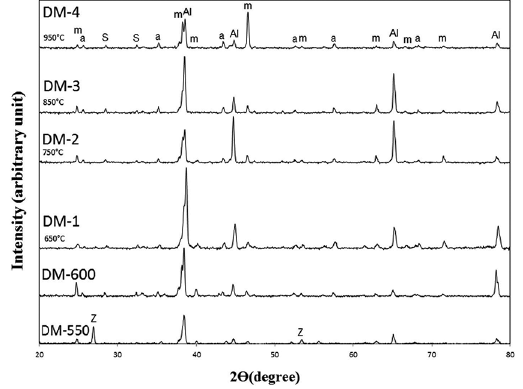
Figure 3: XRD patterns of aluminum composites containing 20 wt.% zircon and 2 wt.% cobalt sintered in microwave at different temperatures. Al: aluminum, a: alumina, z: zircon, s: quartz and m: aluminum-zirconium-silicon intermetallic phase.